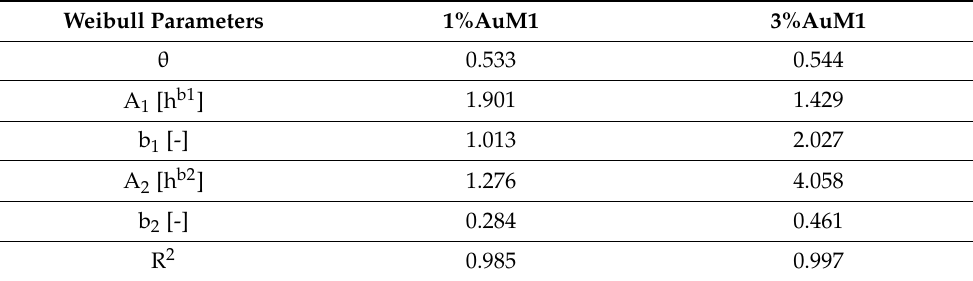
Table 4. Diffusive parameters for diffusive electrospun systems.